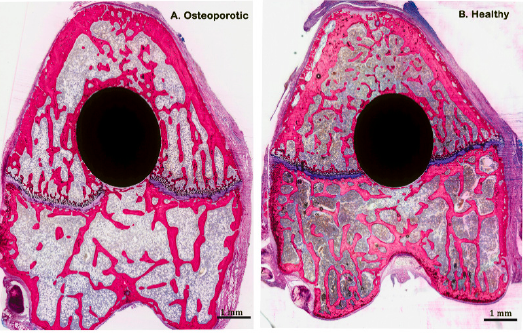
Figure 2. Representative histological images stained with methylene blue and basic fuchsin, showing non-decalcified (pMMA embedded) cross-sections of saline group in both osteoporotic and healthy conditions.